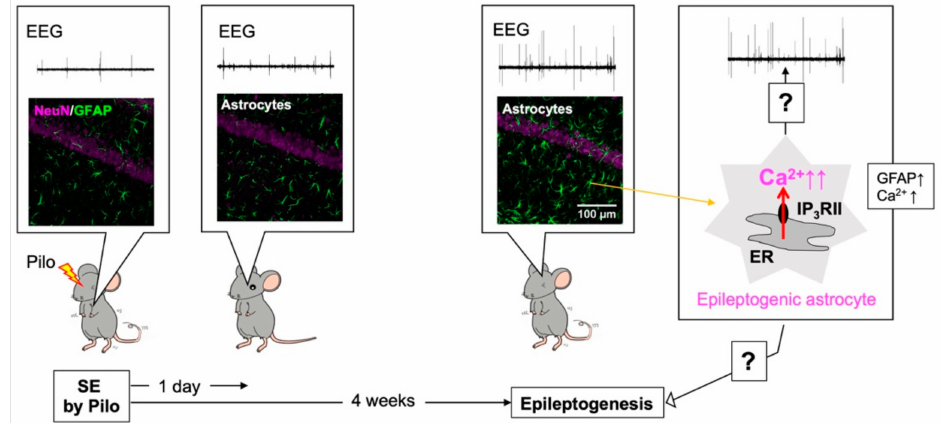
Figure 2. Abnormal Ca 2+ signals in hippocampal astrocytes cause epileptogenesis. Four weeks, but not 1 day, after pilocarpine (Pilo)-evoked status epilepticus (SE), hippocampal astrocytes became reactive and showed increased glial fibrillary acidic protein (GFAP) expression and frequent abnormal Ca 2+ signaling (right cartoon). Reactive astrocytes were highly associated with the development of epileptogenesis as assessed by ictal spikes (electroencephalogram; EEG) or seizure susceptibility to Pilo and, thus, they were named “epileptogenic astrocytes”. Epileptogenesis appeared dependent on abnormal Ca 2+ signaling in epileptogenic astrocytes. The mechanism by which epileptogenic astrocytes cause epileptogenesis is a subject for future